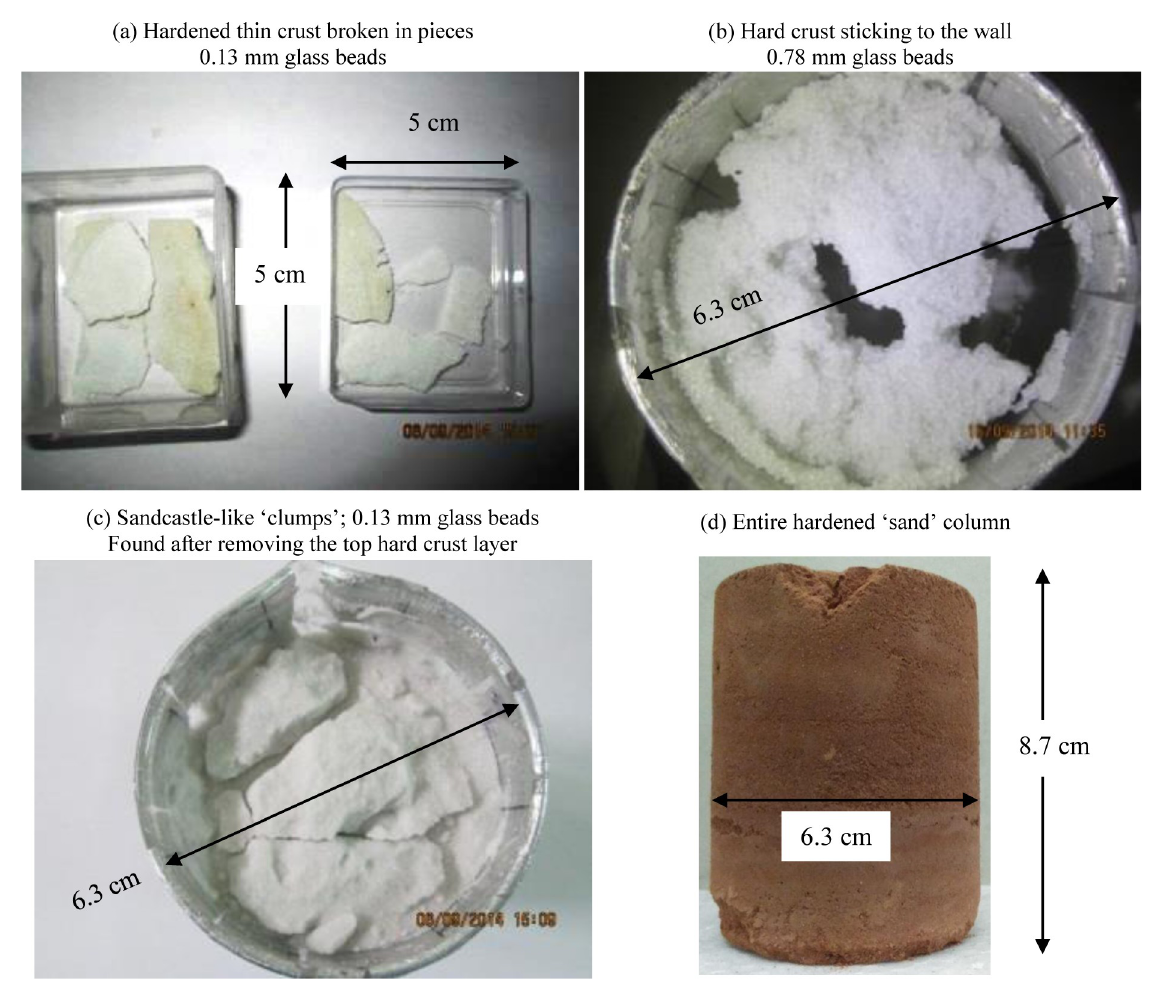
Fig 3. Images at the end of the experiments with different (hydrophilic) samples. Crusts, formed within a few top layers, in the case of (a) 0.13 mm and (b) 0.78 mm diameter glass spheres respectively. Clumps, similar to sandcastles, rather than the crusts are seen (c) at the deeper locations away from the top exposed surface. The crust in case of the natural sand (d) is not limited to a few layers near the top but covers the entire column height. Heat flux incident on the porous media top surface in all the above experiments was ~1000 W/m 2